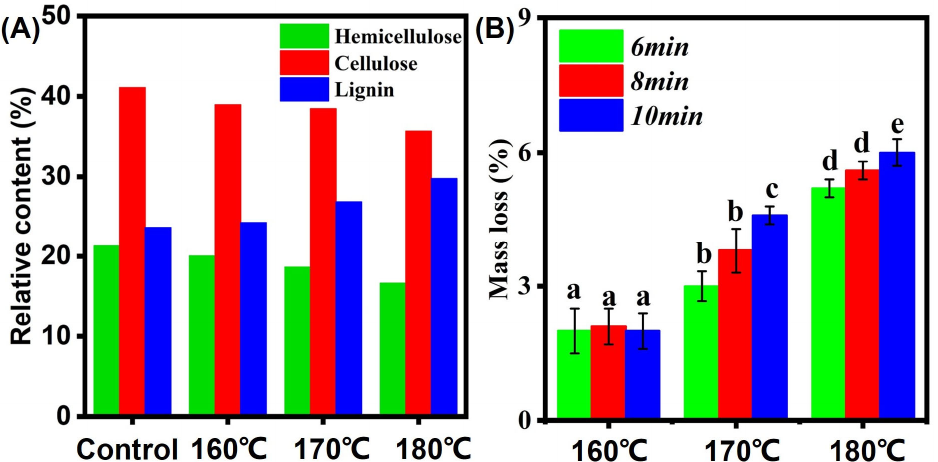
Figure 2. ( A ) Change in three major chemical compositions; ( B ) Mass loss. Different small (a–e) represent the significant difference between heat treatment groups. The error bar in the picture represents the standard deviation.